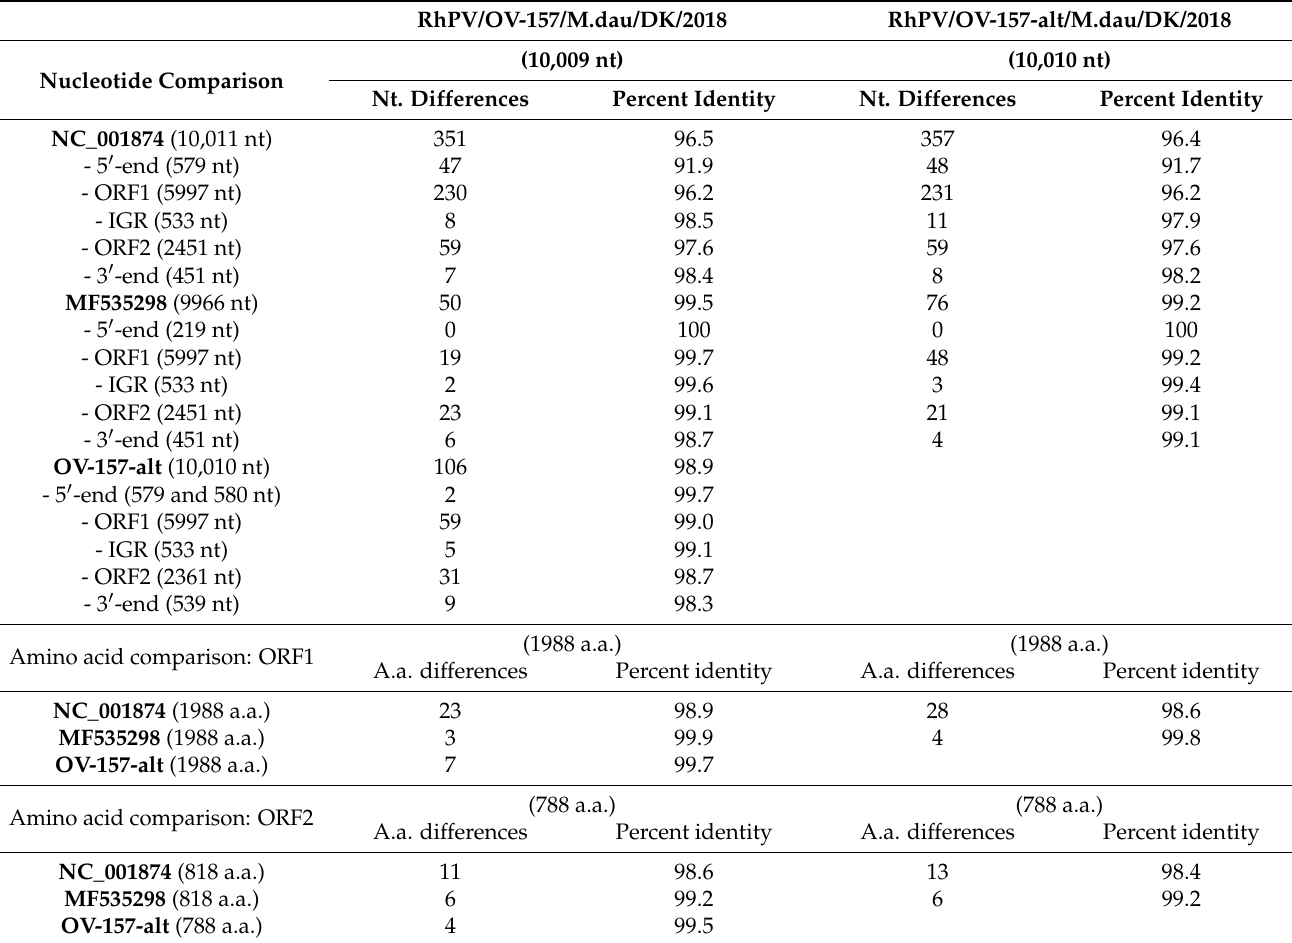
Table 5. Rhopalosiphum padi virus comparisons to one another, to the reference RhPV sequence NC_001874, and to the closely related sequence MF535298 from Hungary